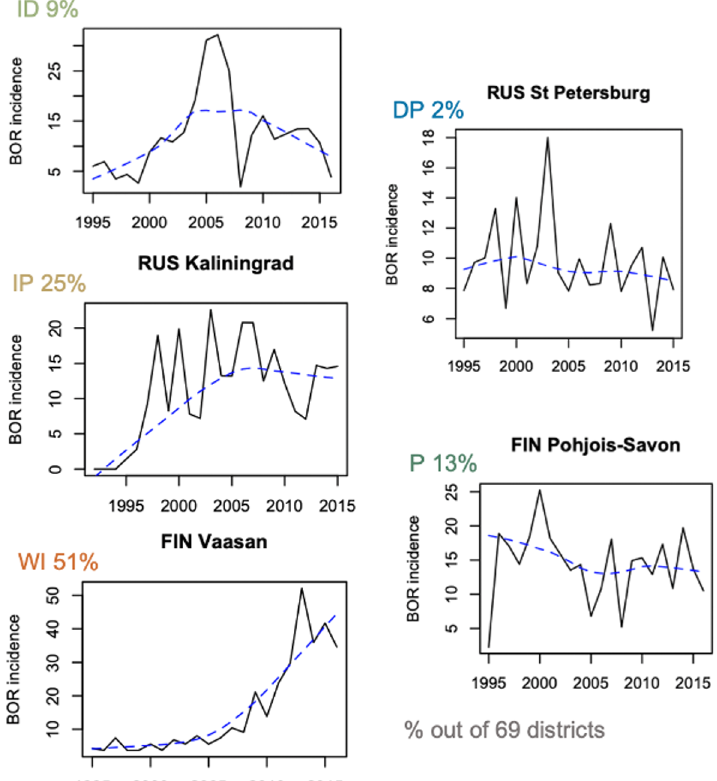
Figure 1. Representative examples of the time series of Lyme borreliosis incidence in districts assigned to the well-increasing (WI), increase–plateau (IP), increase–decrease (ID), plateau (P), and decrease–plateau (DP) groups; the percentages of districts assigned to each group are also indicated; the black line joins the yearly data, and the dotted blue line is the non-parametric local regression smoothed line